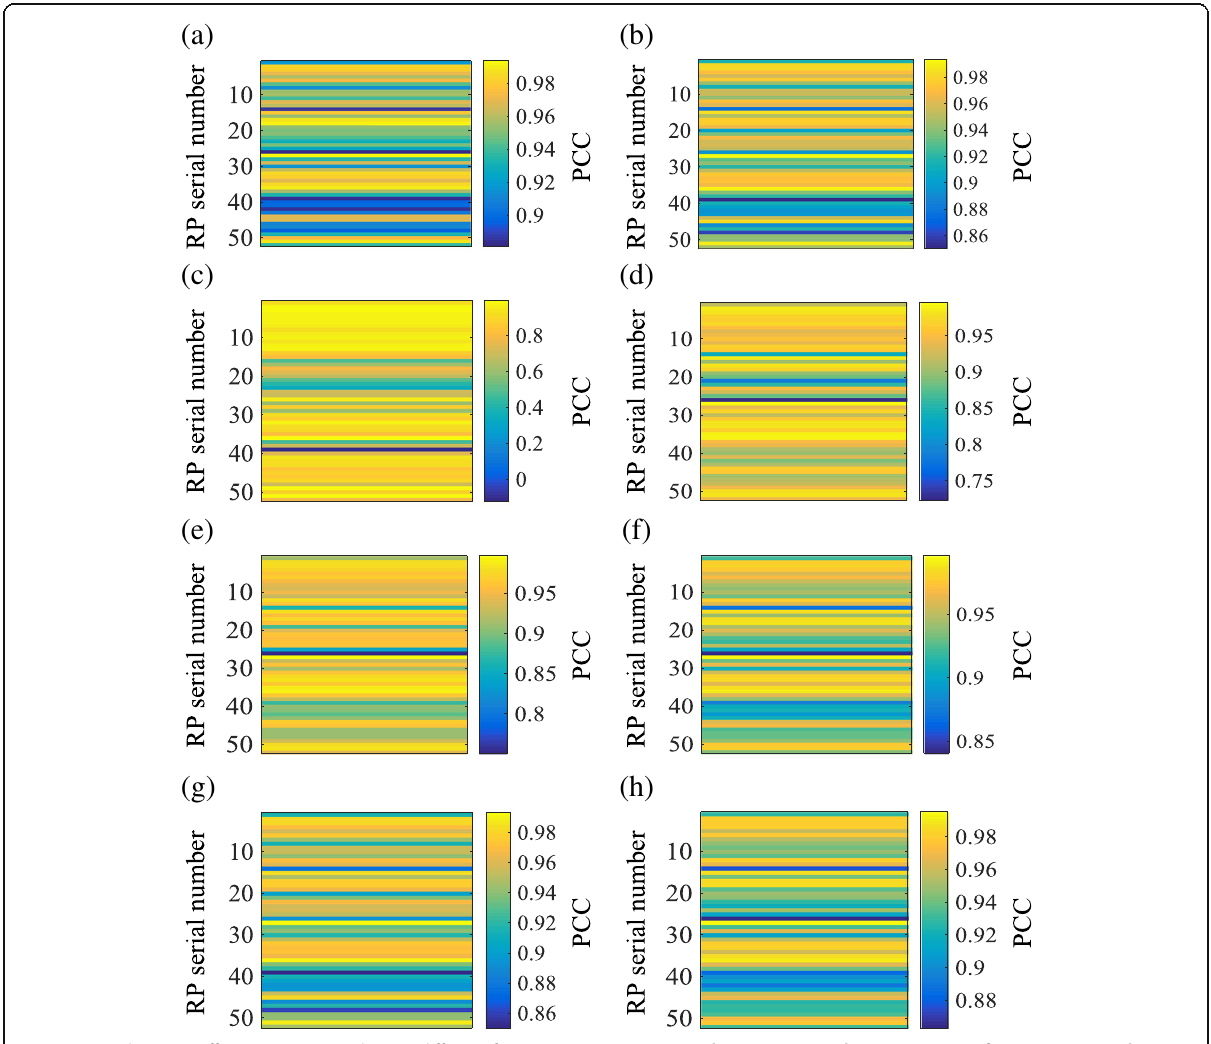
Fig. 12 Correlation coefficients corresponding to different free parameters. a c = 0.01. b c = 1. c c = 5. d c = 10. e c = 20. f c = 30. g c = 40. h c =